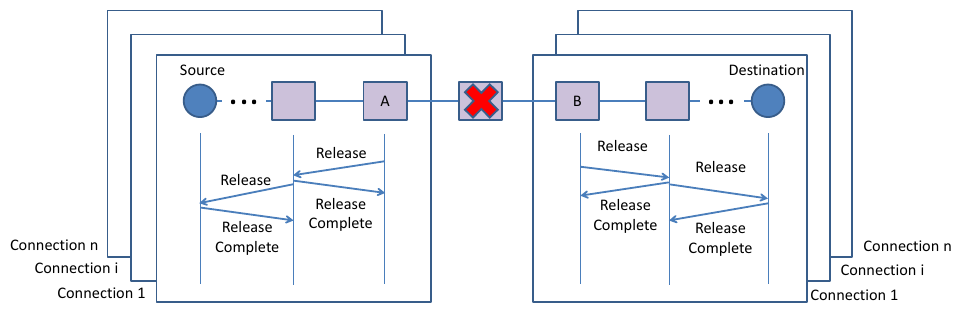
Figure 15. Releasing the allocated communication resources after node